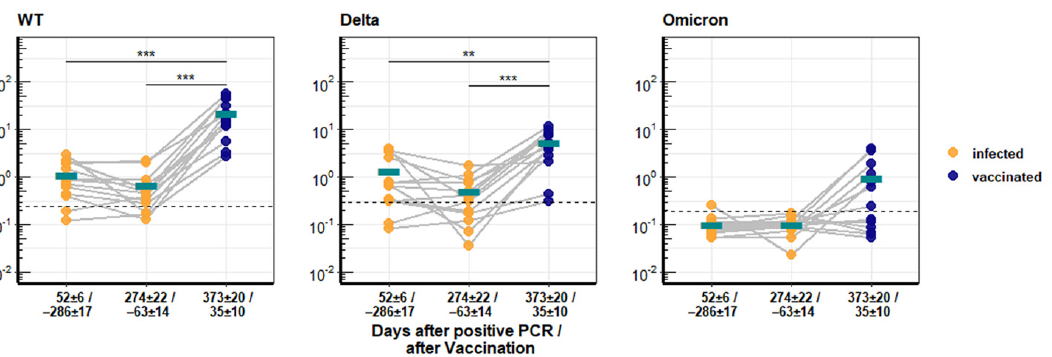
Figure 2. Longitudinal neutralization activity of serum from COVID-19 patients against different SARS-CoV-2 variants of concern. Antibody titers from 13 patients with PCR-confirmed SARS-CoV-2 infection and after vaccination with Comirnaty. Neutralization activity against SARS-CoV-2 WT, Delta, and Omicron was determined with pseudotyped lentiviral vectors and is depicted as reciprocal area under the curve. The turquoise bars give the respective arithmetic means of all samples, and asterisks indicate significant changes. Significance is indicated with three stars (***) for a p -value ≤ 0.001 and two stars (**) for a p -value ≤ 0.01. Serum from recovered patients had no neutralizing activity against the Omicron variant, but the Comirnaty vaccination increased the neutralization activity against Omicron to detectable levels in half of the patients (Figure 2), although the mean reciprocal AUC of 0.98 was very low.